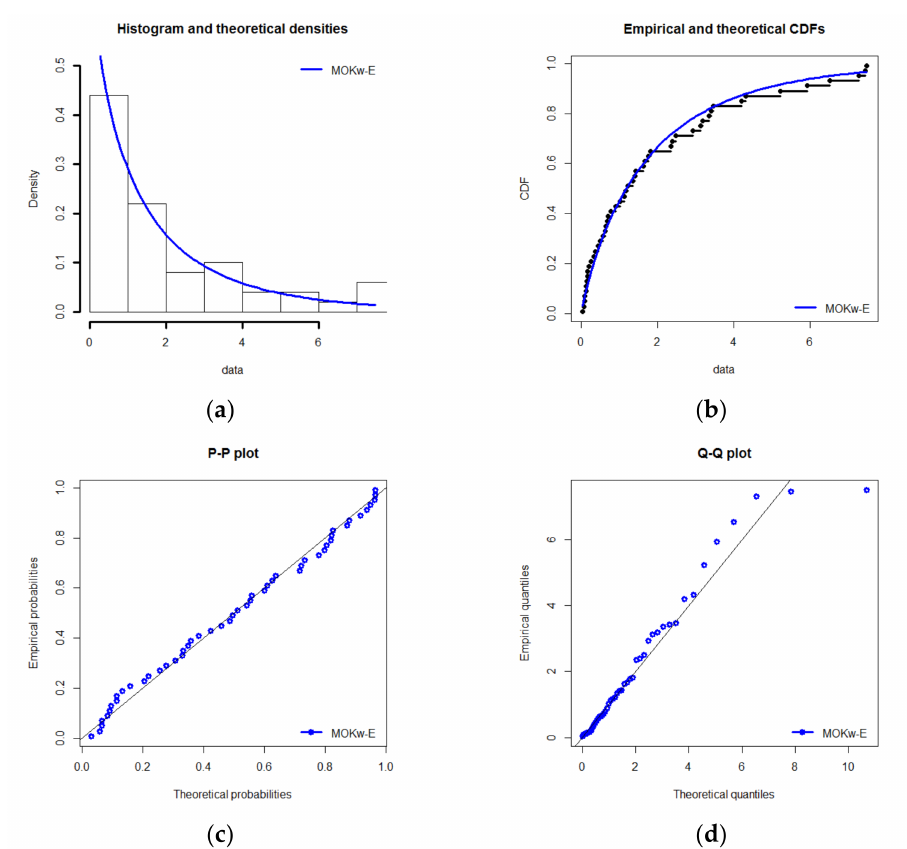
Figure 1. Examples of fits of MOKw-E for the carbon fibers dataset: ( a ) histogram fitted by the estimated pdf, ( b ) empirical cdf fitted by the estimated cdf, ( c ) P–P plot, and ( d ) Q–Q plot.